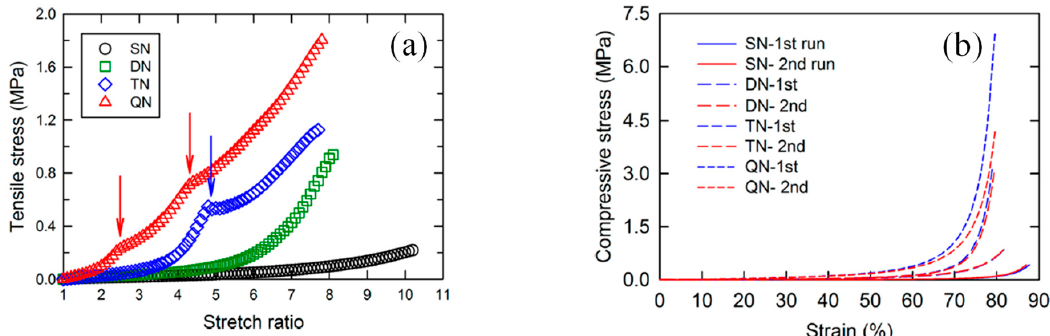
Figure 10. ( a ) Tensile stress–strain curves for the single-network (SN), double-network (DN), triple-network (TN), and quadruple-network (QN) hydrogels. Arrows show the strain localization points in the TN and QN hydrogels. ( b ) Compressive stress–strain curves for the SN, DN, TN, and QN hydrogels. Blue lines show the first compression run on the sample, and the red lines show the second compression after the first run on the same sample. Adapted and reprinted with permission from [28].